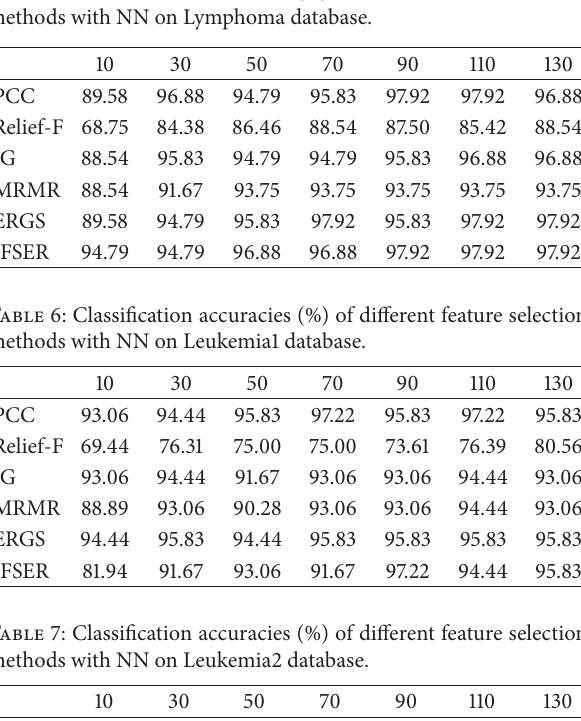
Table 5: Classification accuracies (%) of different feature selection methods with NN on Lymphoma database.